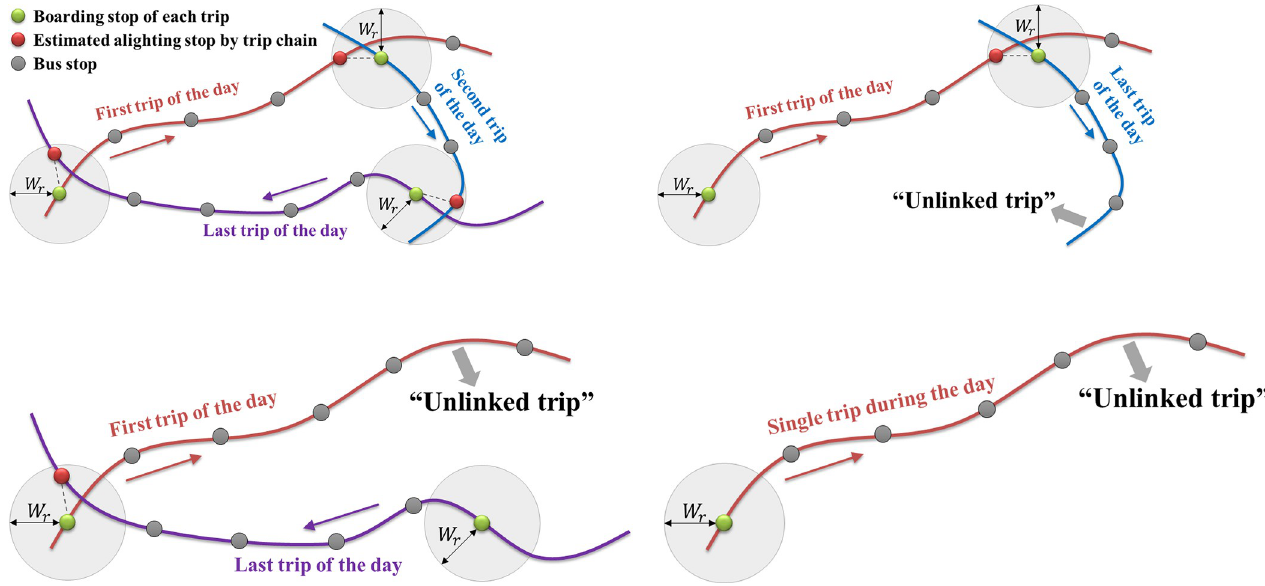
Fig 1. Trip chain method and cases of unlinked